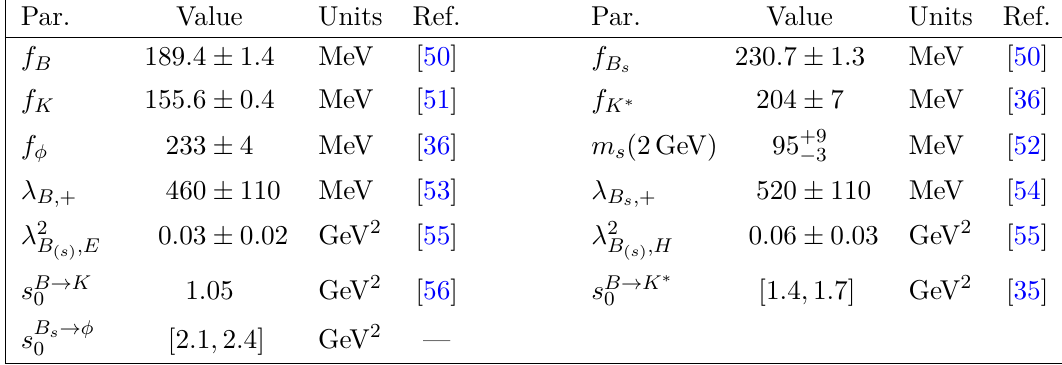
Table 2 . List of the input parameters used in the evaluation of the LCSR (2.30). The intervals for the effective thresholds s B → K ∗ form